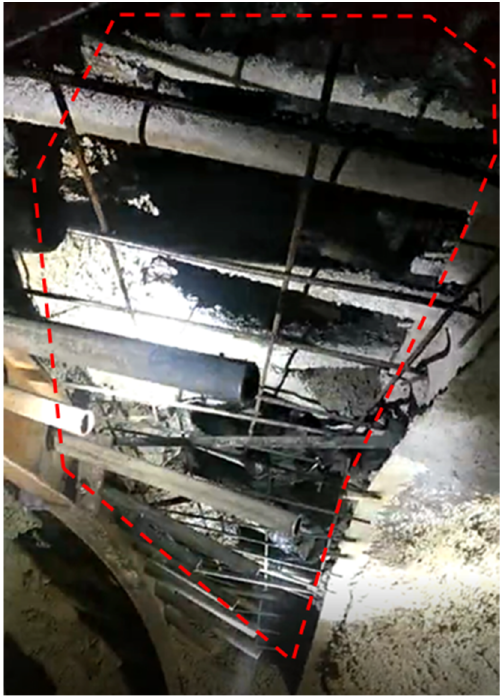
Figure 14. Softening and collapse area of surrounding rock behind the arch.